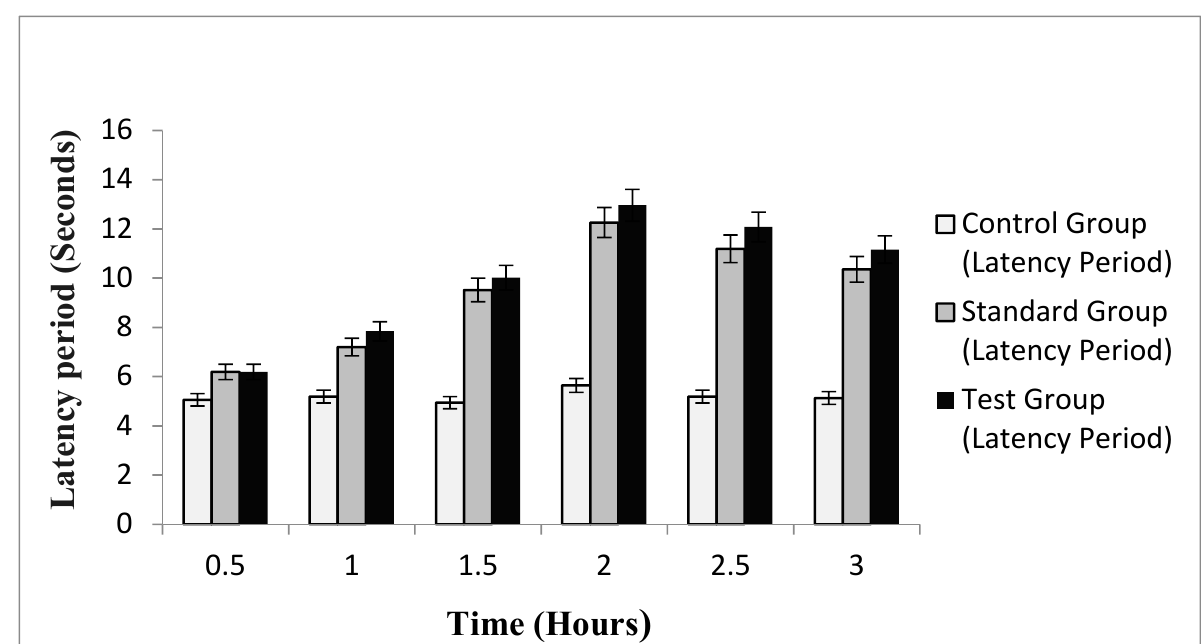
Figure 3. Latency period of control, standard and test group.